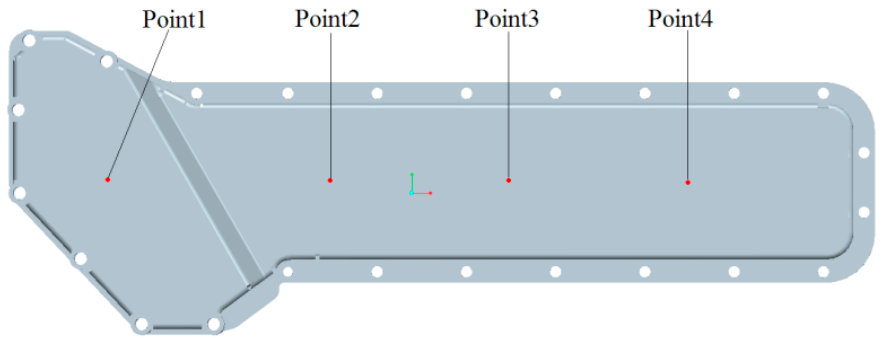
Figure 20. Sketch of the response points on the oil cooler cover.